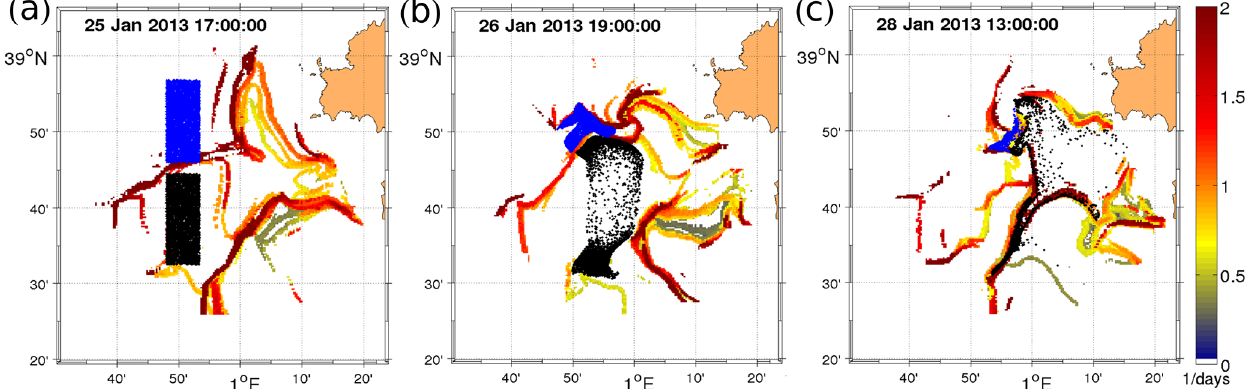
Figure 10. Evolution of two sets of particles (black and blue) in the area covered by the HFR-Ibiza in January 2013 superimposed on the backward finite-size Lyapunov exponent – FSLE (color bar). The virtual particles are initially deployed at both sides of a barrier revealed by a zonal LCS on 25 January 2013 at 17:00 evolving for